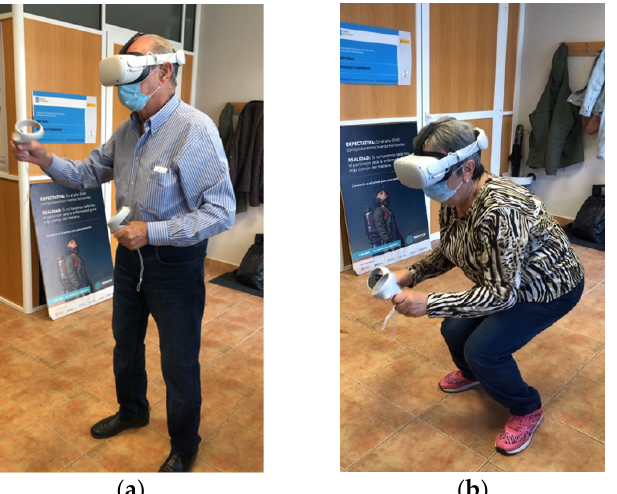
Figure 3. Participants during individual sessions. ( a ) Patient train for speed and strength in upper limbs while hitting balls. ( b ) Participant train for balance and endurance in lower limbs while avoiding